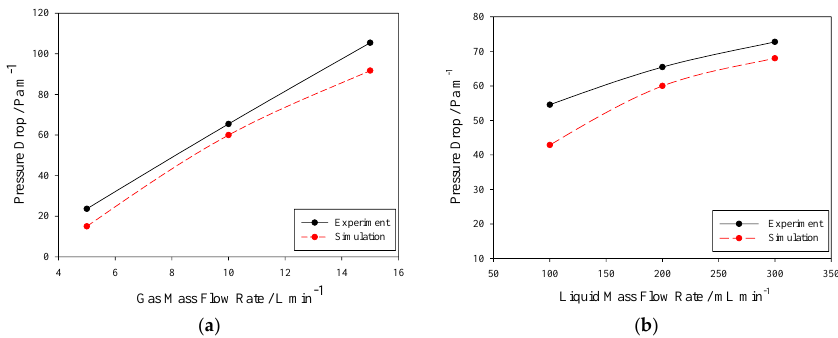
Figure 4. Pressure drops obtained from experiments and simulation using six differen t conditions. ( a ) Pressure drop as a function of gas flow rate at a fixed liquid flow rate of V L = 200 mL/min; ( b ) pressure drop as a function of liquid flow rate at a fixed gas flow rate of V g = 10 L/min.